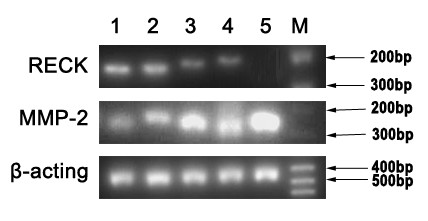
Representative gel pictures showing the mRNA expression of RECK and MMP-2. M, DNA marker; 1 and 2, Keratocystic odontogenic tumor; 3 and 4, Ameloblastoma; 5, Ameloblastic carcinoma.